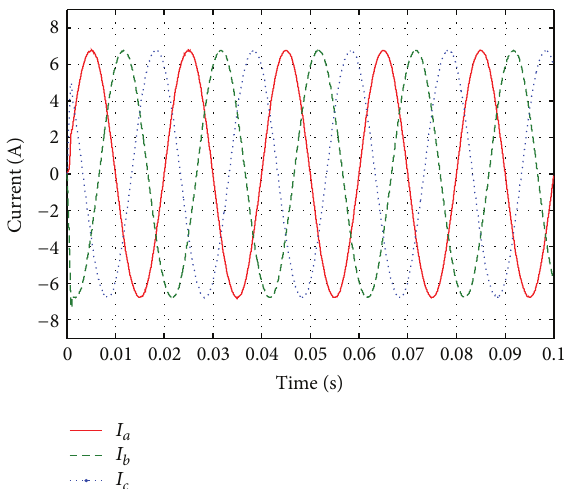
Figure14:Outputcurrentwaveforms(i.e., 𝐼 𝑎 , 𝐼 𝑏 ,and 𝐼 𝑐 )ofthethree- phase inverter with 𝑅 load.